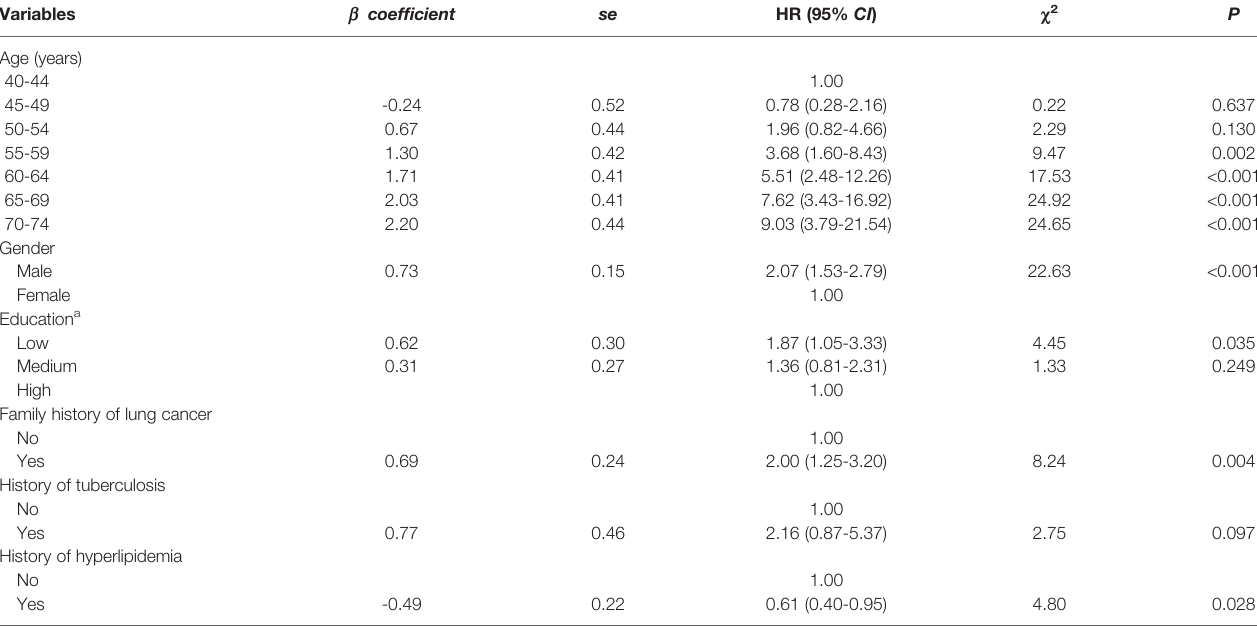
TABLE 2 | Multivariable Cox-regression prediction model of lung cancer risk in training set.